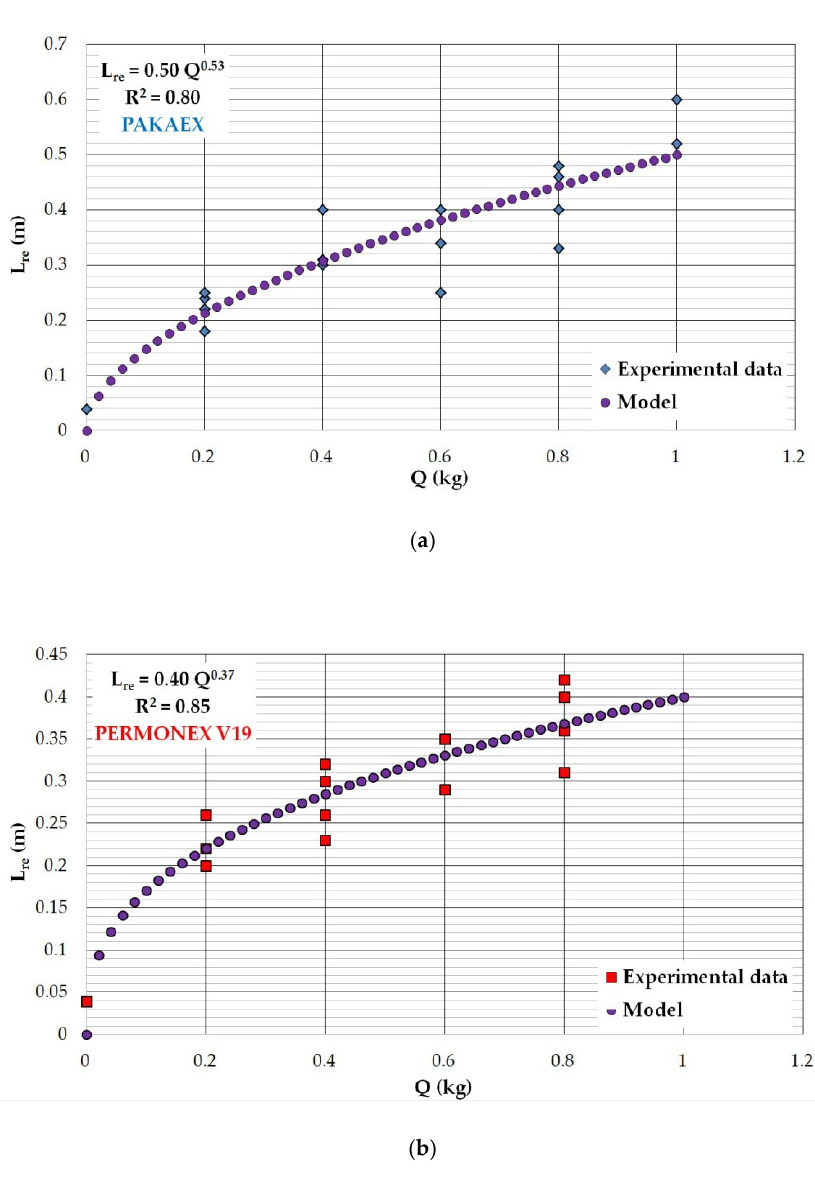
Figure 15. ( a ) The mathematical model plots of the lowest AIC c values for the resulting deepening L re (m) for Pakaex. ( b ) The mathematical model plots of the lowest AIC c values for the resulting deepening L re (m) for Permonex V19.